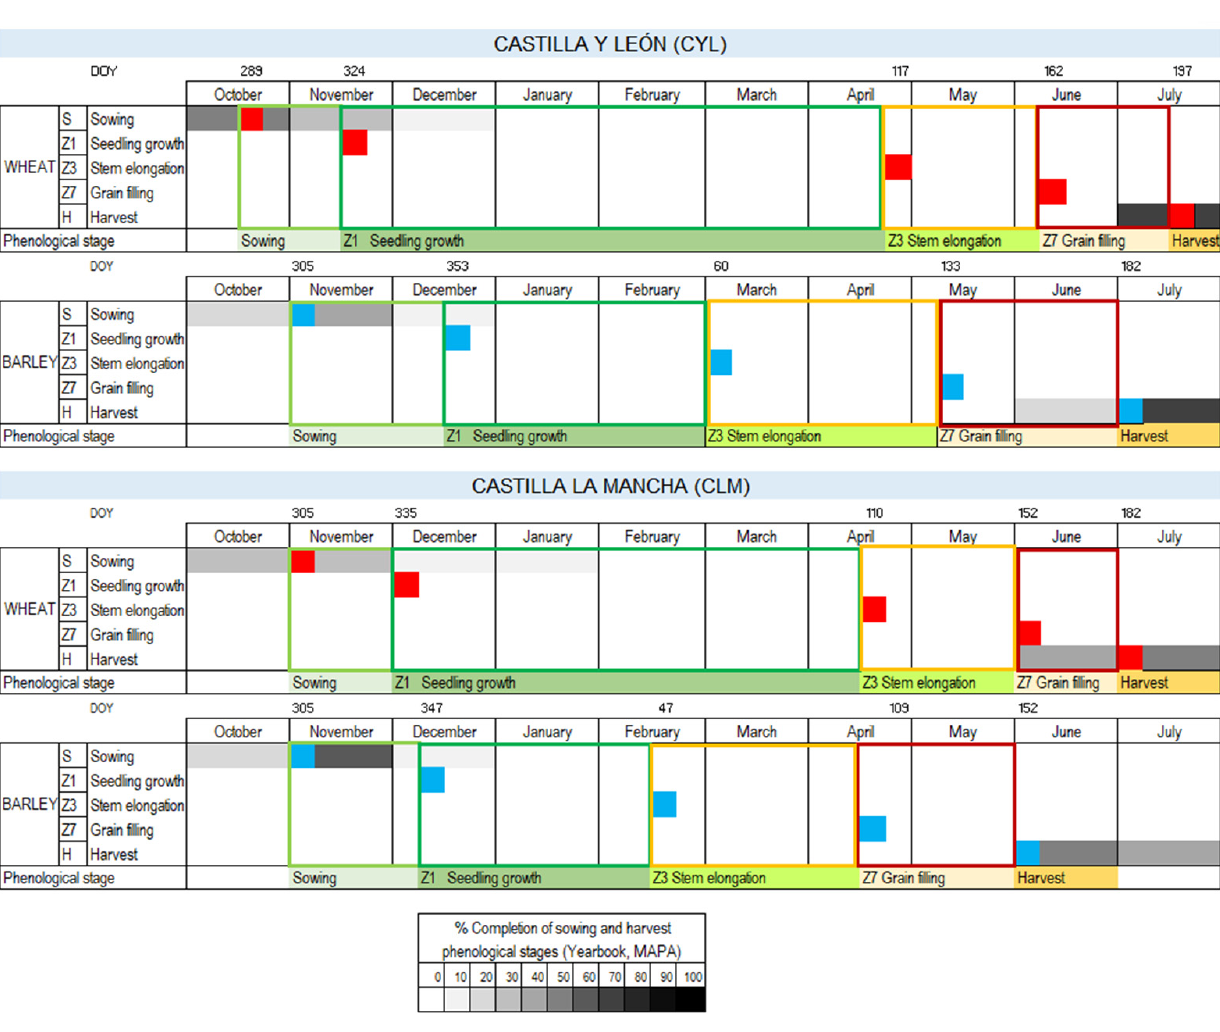
Figure 2. Weekly calendar of the growing season indicating the estimated starting dates (red for wheat, blue for barley) of the major phenological stages in the CYL and CLM regions. The average sowing and harvest dates of each region are based on the sowing, harvesting, and marketing calendar of MAPA Ref. [55]. The dates of intermediate phenological stages are estimated on the crop guide of FAO. Sowing and harvesting dates are displayed as graduated grays, depending on the % of completion of these activities conducted in the month.